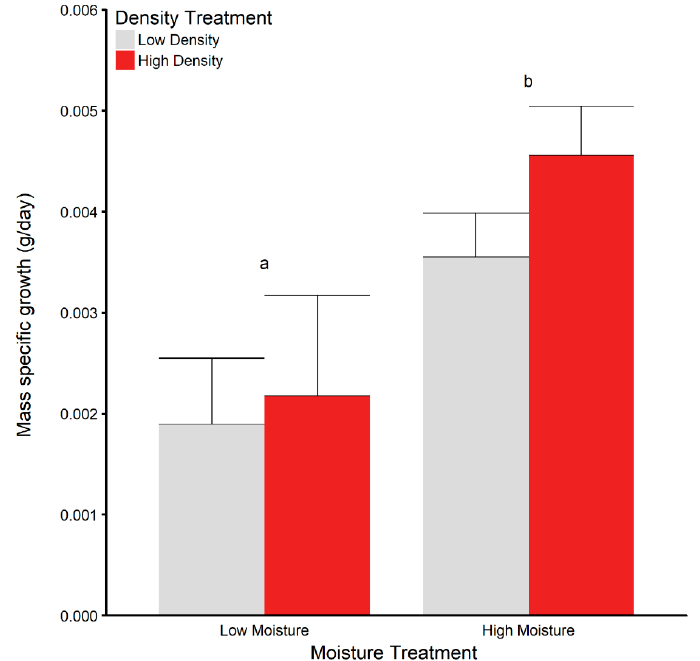
Figure 3. Mean mass-specific growth rates across low and high terrestrial moisture treatments and low larval density (grey bars) and high larval density treatments (red bars) + SE. Letters over bars represent significant differences between moisture treatments at p = 0.05.